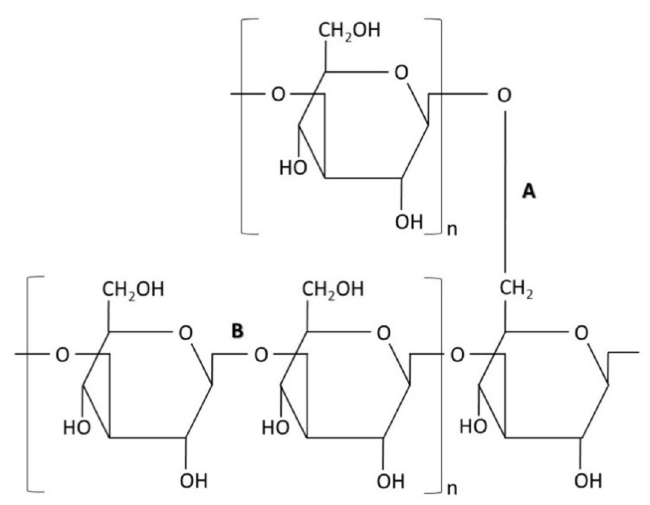
Figure 2. Glucan structure shows the ( A ) β -1,6 linkages and ( B ) β -1,3 linkages.